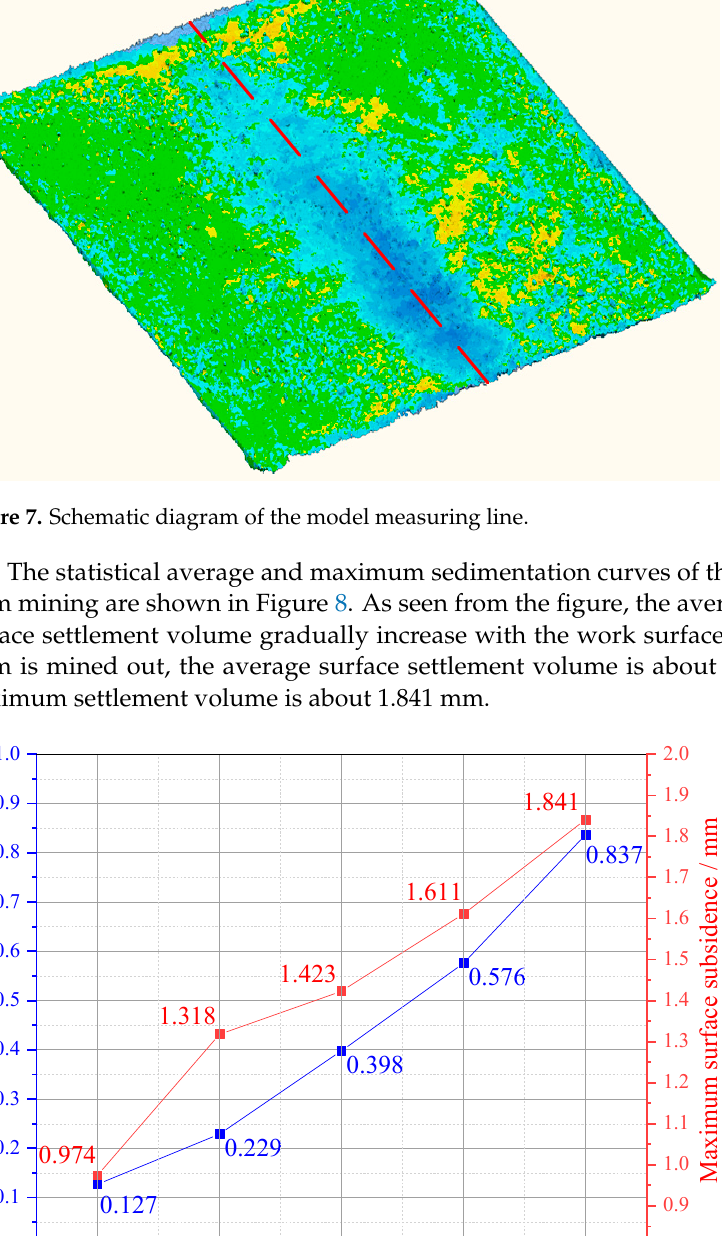
Figure 8. Statistical curve of surface settlement.